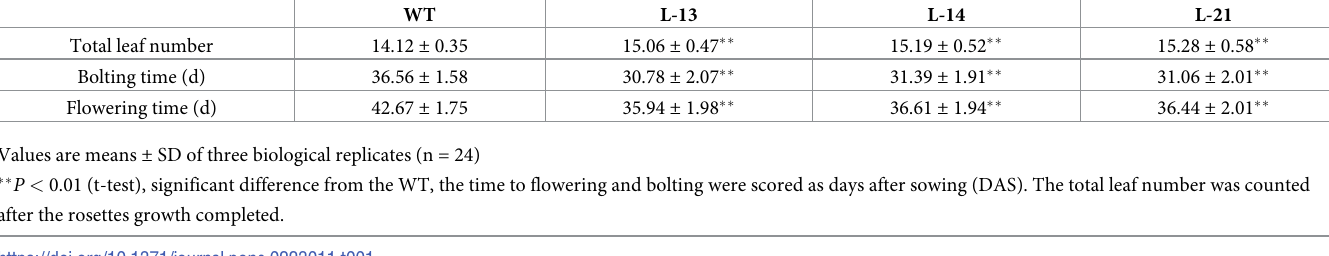
Table 1. Total leaf number, Bolting and flowering times of WT and 35S-OsATG8b transgenic Arabidopsis.